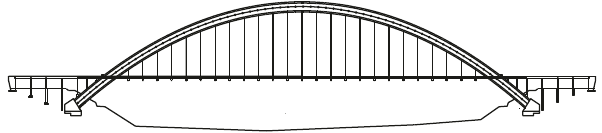
Figure 1: SRC arch bridge elevation.